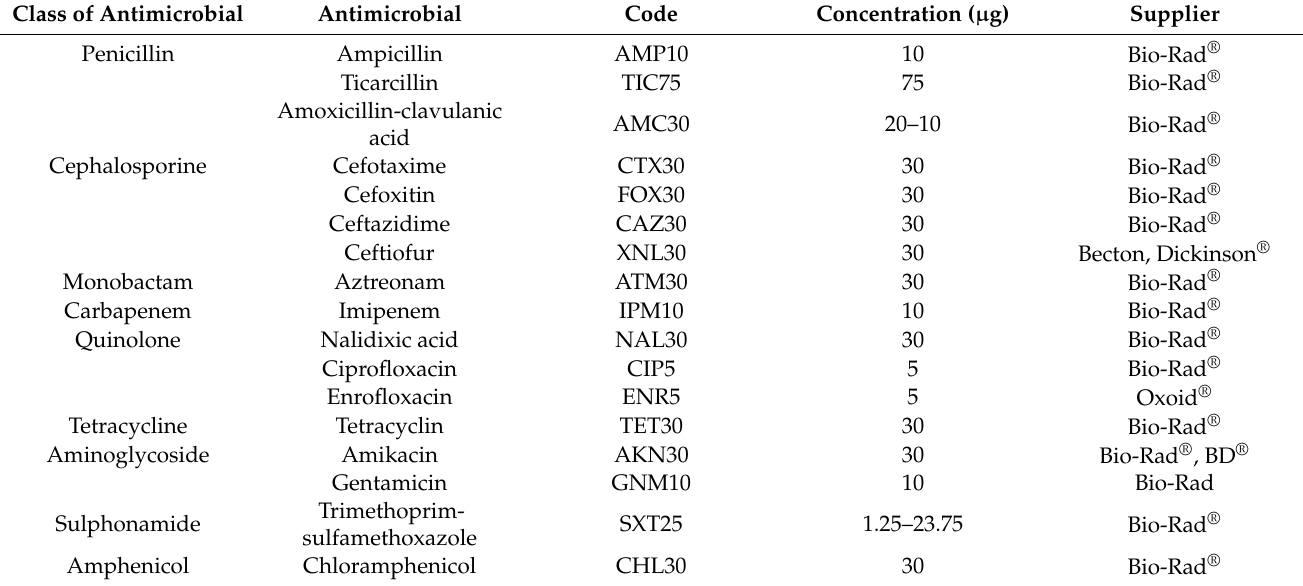
Table 1. Antimicrobial disks used in this